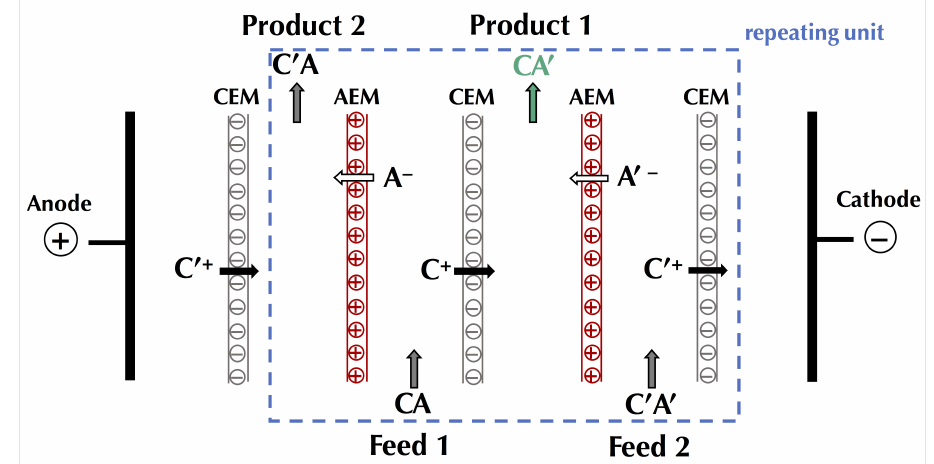
Figure 16. Principle of electrodialysis